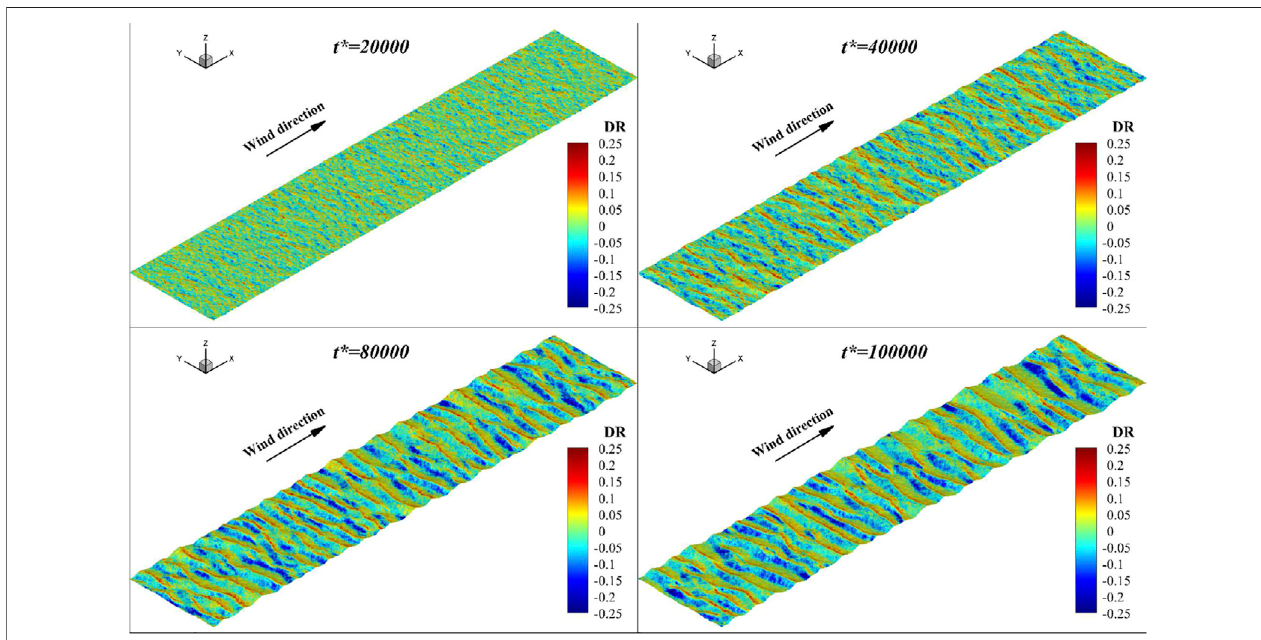
FIGURE 12 | 3D view of aeolian sand ripple development.